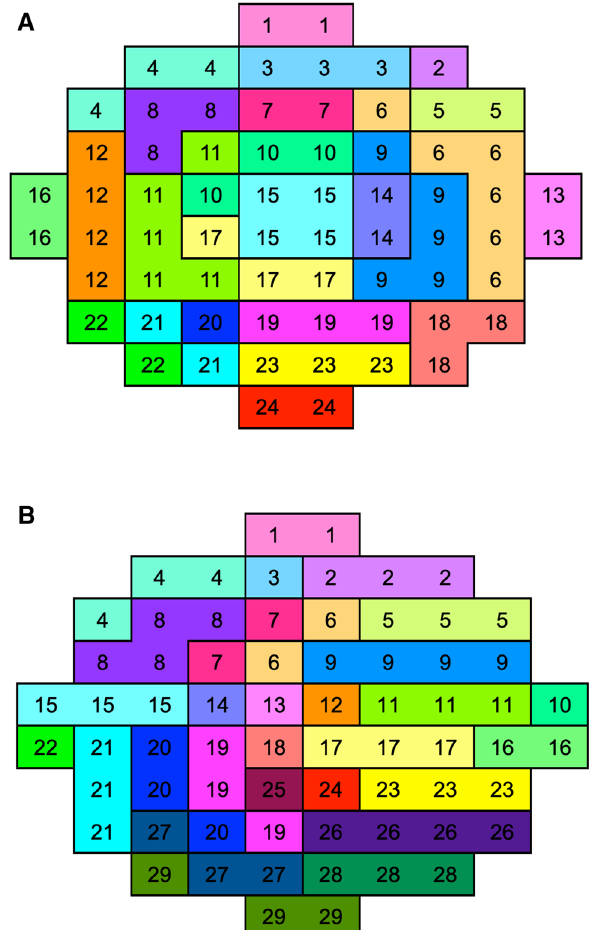
Figure 1. Cluster mappings of the HFA 10-2 test (right eye). The 68 test points of the HFA 10-2 test were stratified into 24 sectors ( A : S1). The sectors of S2 mapping ( B : 29 clusters) was derived from previous study in glaucoma 16 . The left eye was mirror